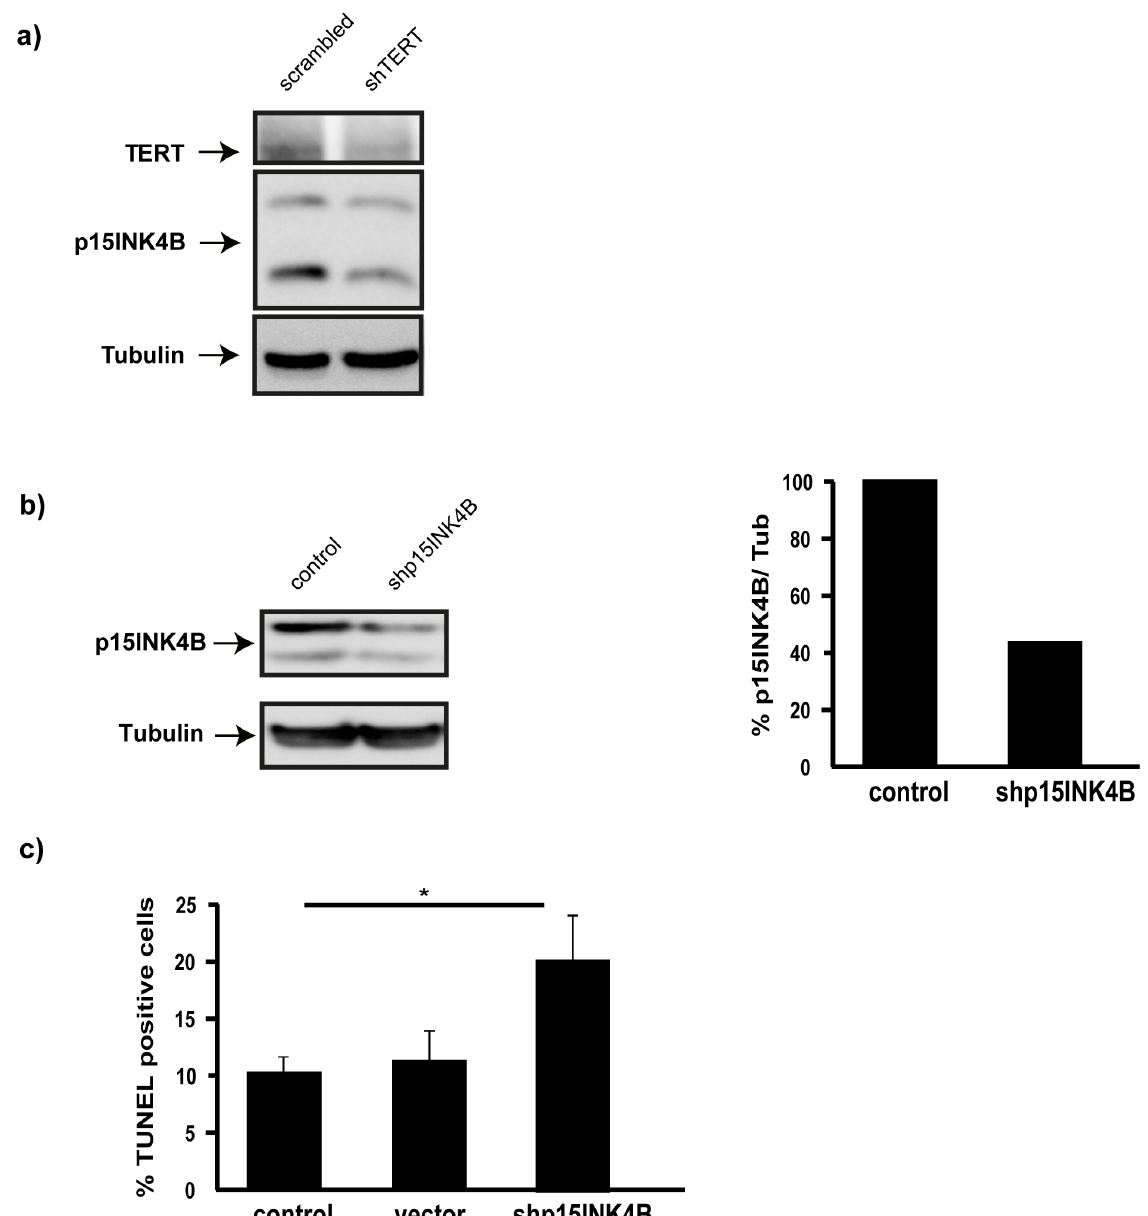
Figure 4. TERT exerts its anti-apoptotic role through regulation of p15INK4B messenger, a ) Western blot analysis of TERT and p15INK4B levels in 10 DIV hippocampal neurons infected with scrambled or shTERT; Tubulin is used as loading control. Note that p15INK4B levels are reduced by TERT downregulation (n=2). b) Western blot analysis of p15INK4B levels in control 10 DIV hippocampal neurons and infected with p15INK4B shRNA. The reduction in protein content is more than 50% (bar graph on the right, n=2). c) Tunel assay of 10 DIV hippocampal neurons under control conditions (control) and after infection with an empty vector (vector) or with the shRNA for p15INK4B (shp15INK4B). The bar graph illustrates the significant cell death under this last condition (mean 6 the s.d. of three different cultures; * p , 0.05).